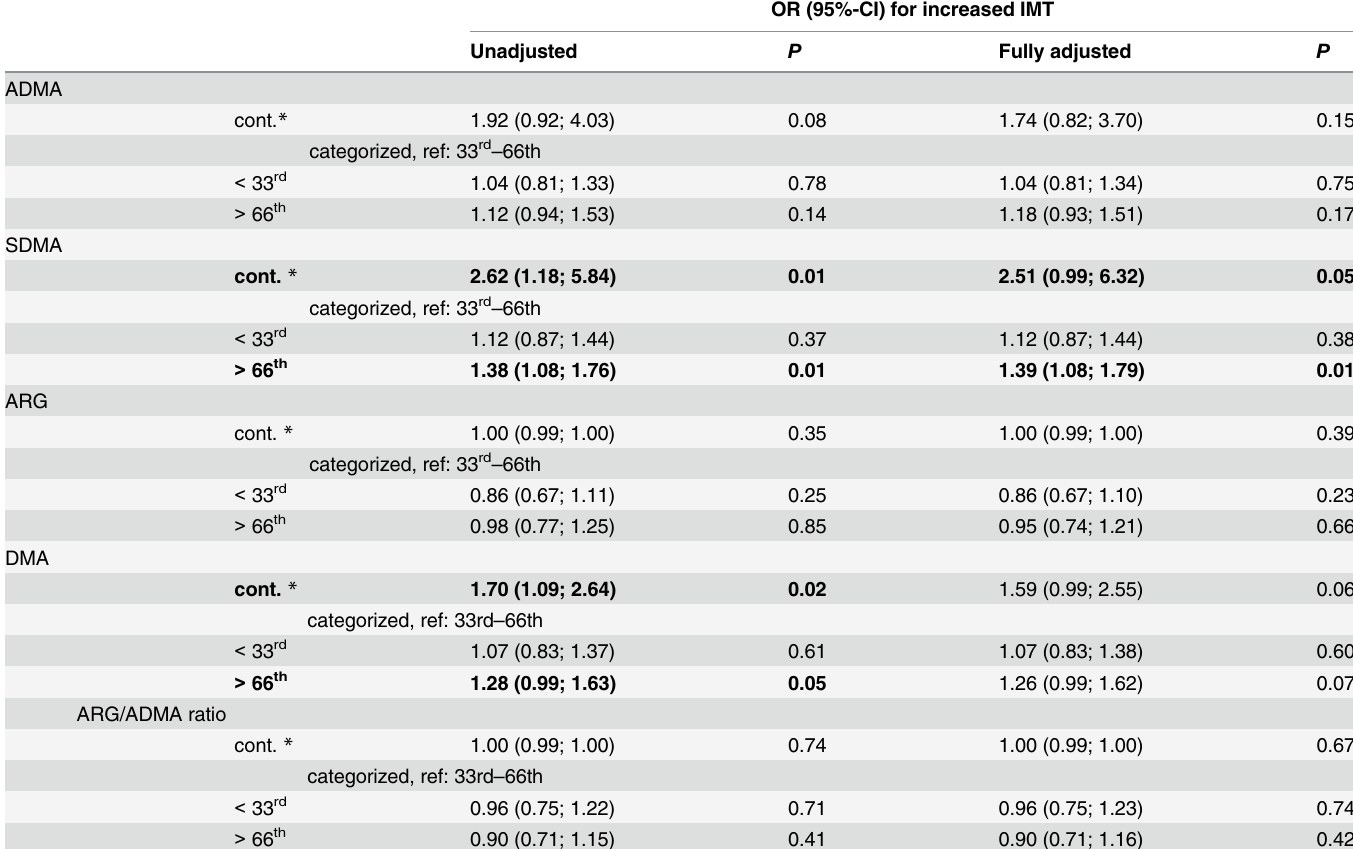
Table 2. Association of arginine derivatives with increased